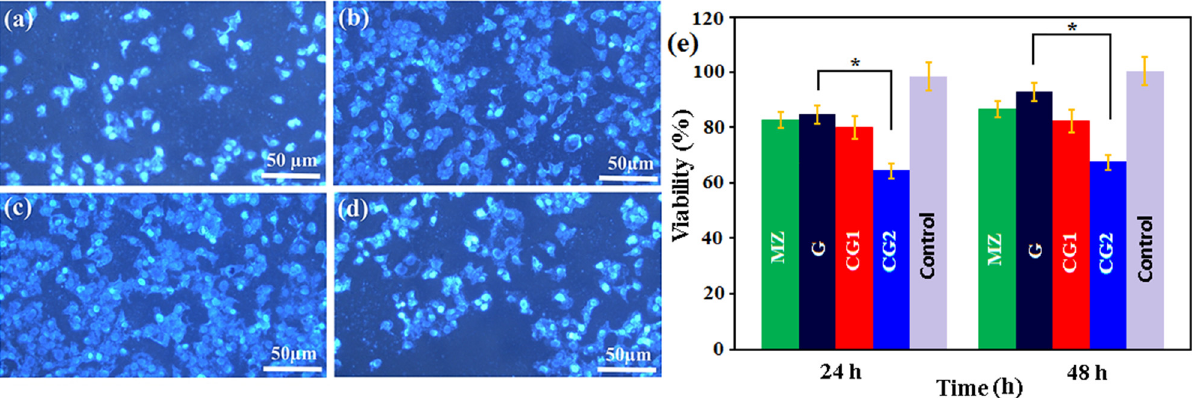
Figure 9. Fluorescent microscopic images of ( a ) MZ, ( b ) MZ/GO (G), ( c ) MZ/1GO-Cu (GC1), ( d ) MZ/2GO-Cu (GC2), and ( e ) cell viability of MG63cells cultured for 24 and 48 h on MZ/GO-Cu composites (* p <